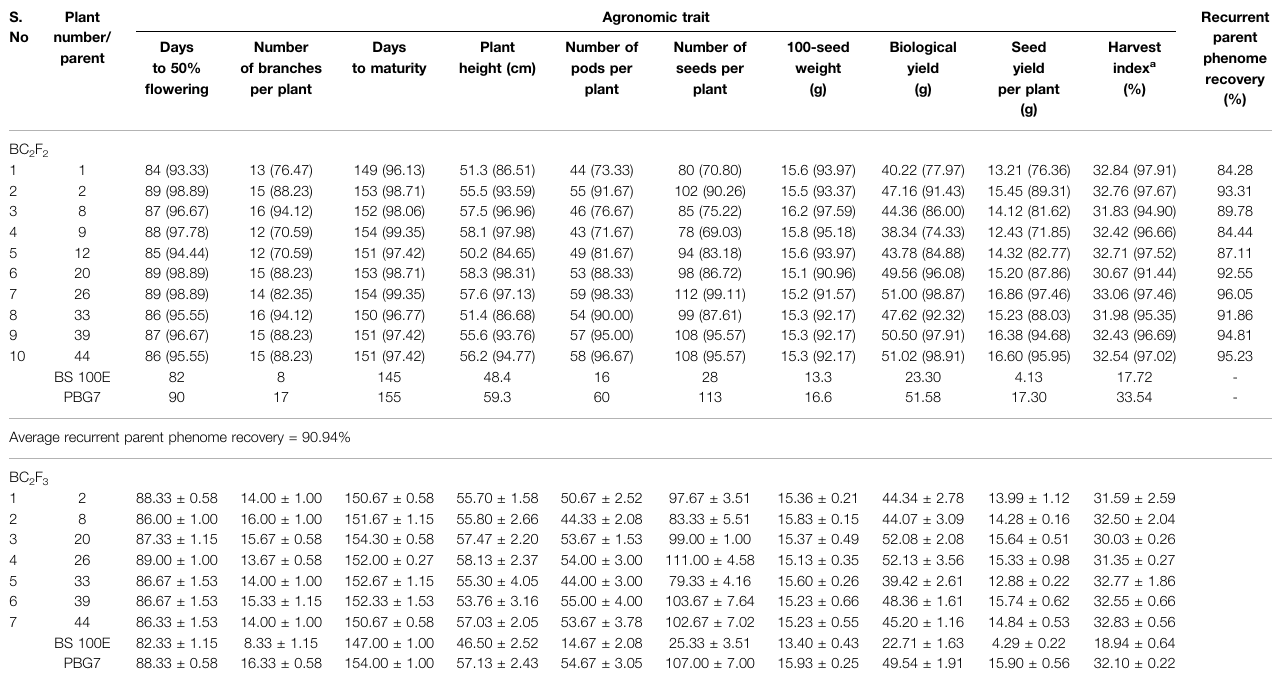
TABLE 3 | Agronomic traits of BC 2 F 2 and BC 2 F 3 populations derived from Cross C (PBG7 × BS 100E). S. Plant No number/ parent